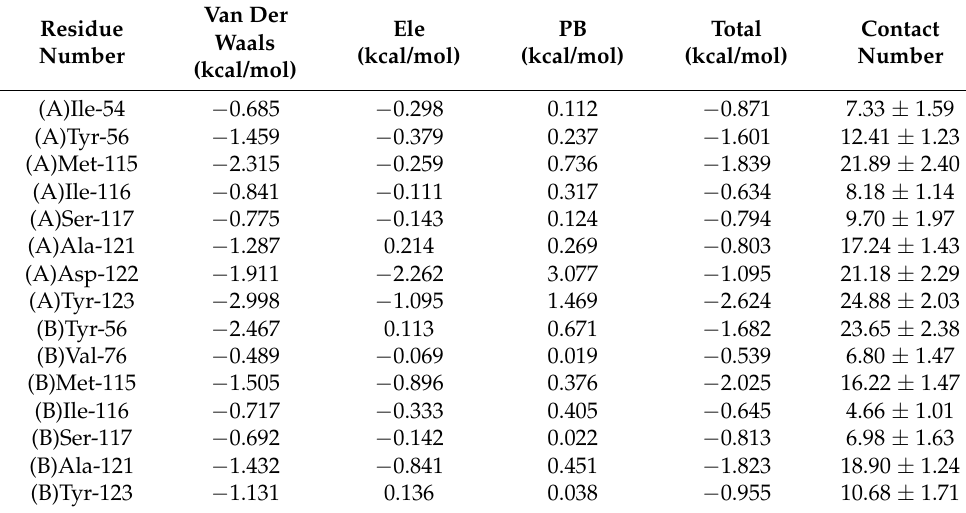
Table 5. Curcumin per-residue energy decomposition.